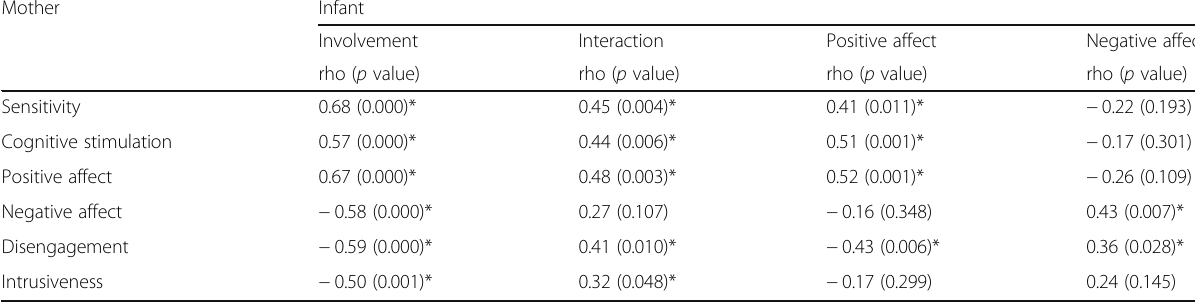
Spearman ’ s correlation; * p